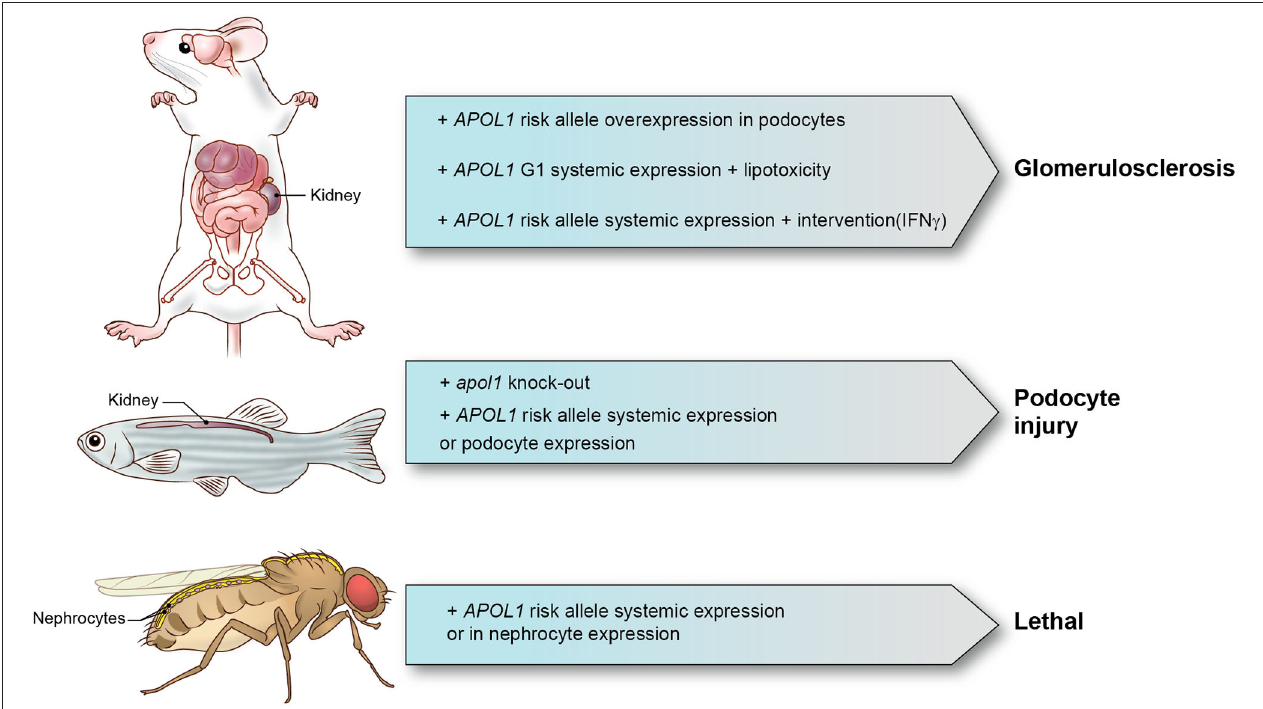
FIGURE 1 | APOL1 animal models and phenotypes. Representative APOL1 animal models with interventions and phenotypes are shown.